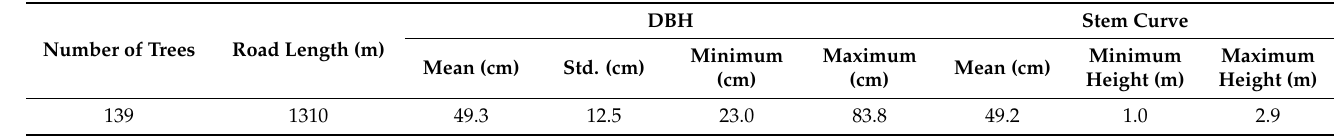
Table 1. Descriptive statistics of the roadside trees located in the test area based on the manual field measurements. The data in the table include the total number of reference trees, the total length of the road under study, mean of DBH, standard deviation of DBH, minimum DBH, maximum DBH, mean diameter of the stem curves, and the mean of the lowest and highest height, at which the stem diameter is manually